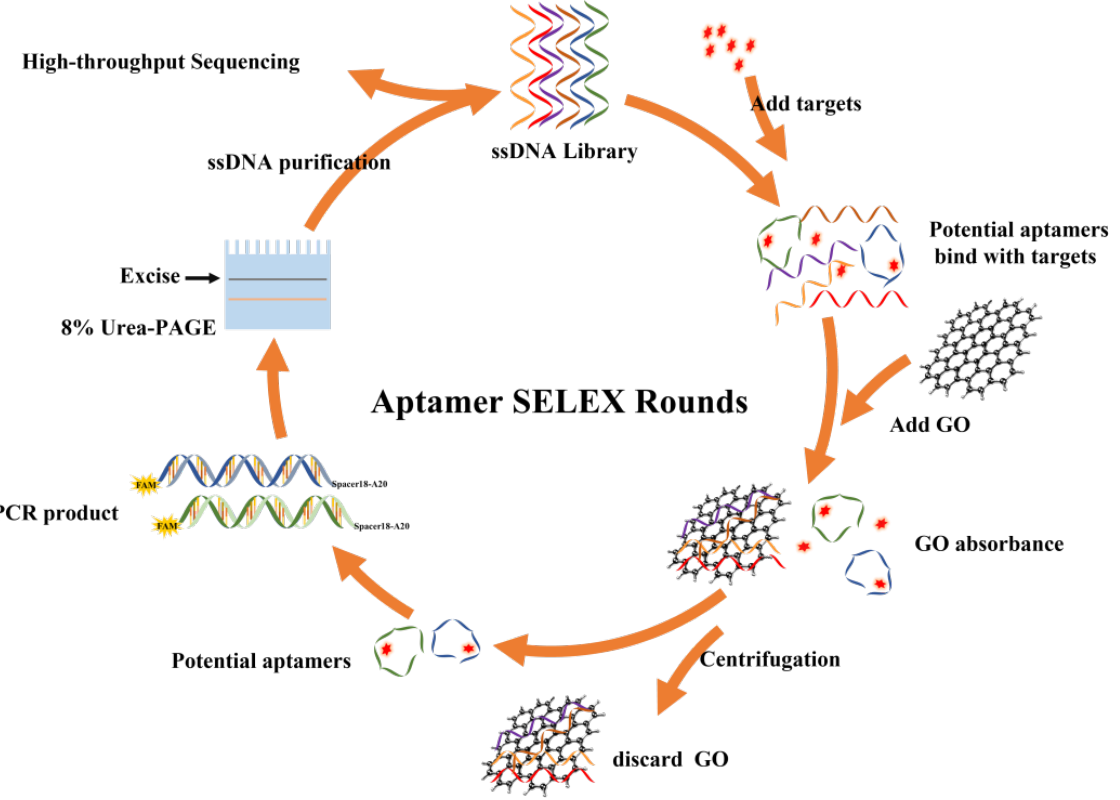
Figure 1. Schematic diagram for screening thiamethoxam aptamers by GO-SELEX.